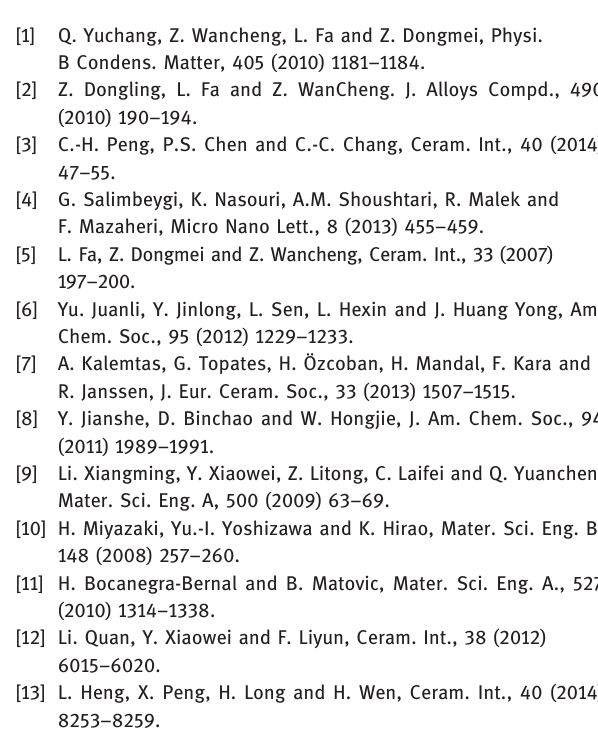
Figure 10: The schematic diagram of absorbing of Si 3 N 4 /BN(CB) composite